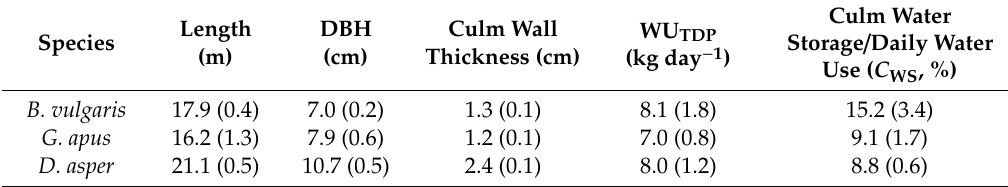
Table 1. Basic information on culms of the bamboo species B. vulgaris, G. apus, and D. asper (four culms for B. vulgaris , three culms for G. apus and D. asper ) for the deuterium study: length (m), diameter at breast height (DBH, cm), culm wall thickness (cm), daily water use estimates as based on TDP measurements (WU TDP , kg day − 1 ), and contribution of culm water storage to daily water use ( C WS , %). Means and standard errors. Note that the length of each culm was obtained by measuring the length of the culm from base to top after cutting down the culm at the end of the experiment.